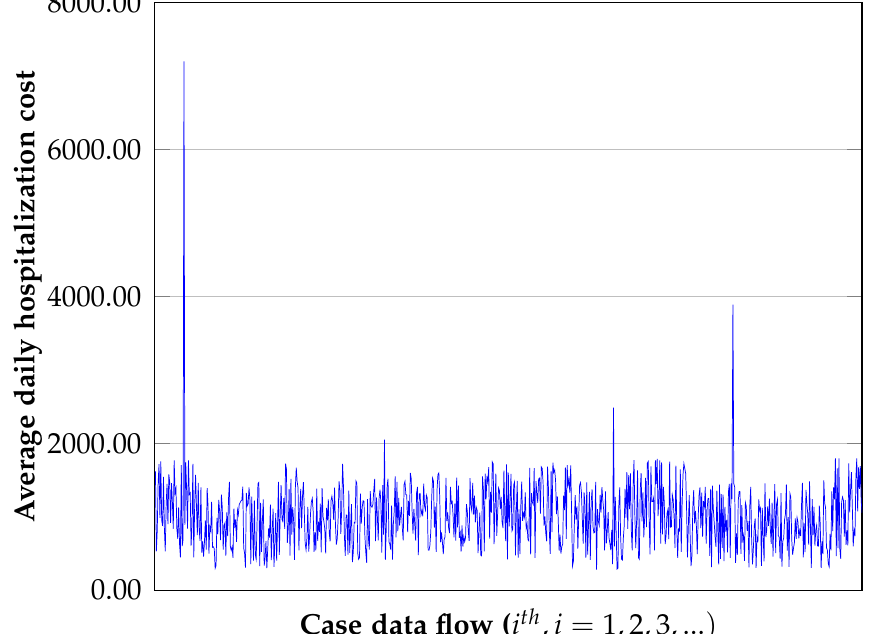
Figure 7. Data flow diagram of a dimension of